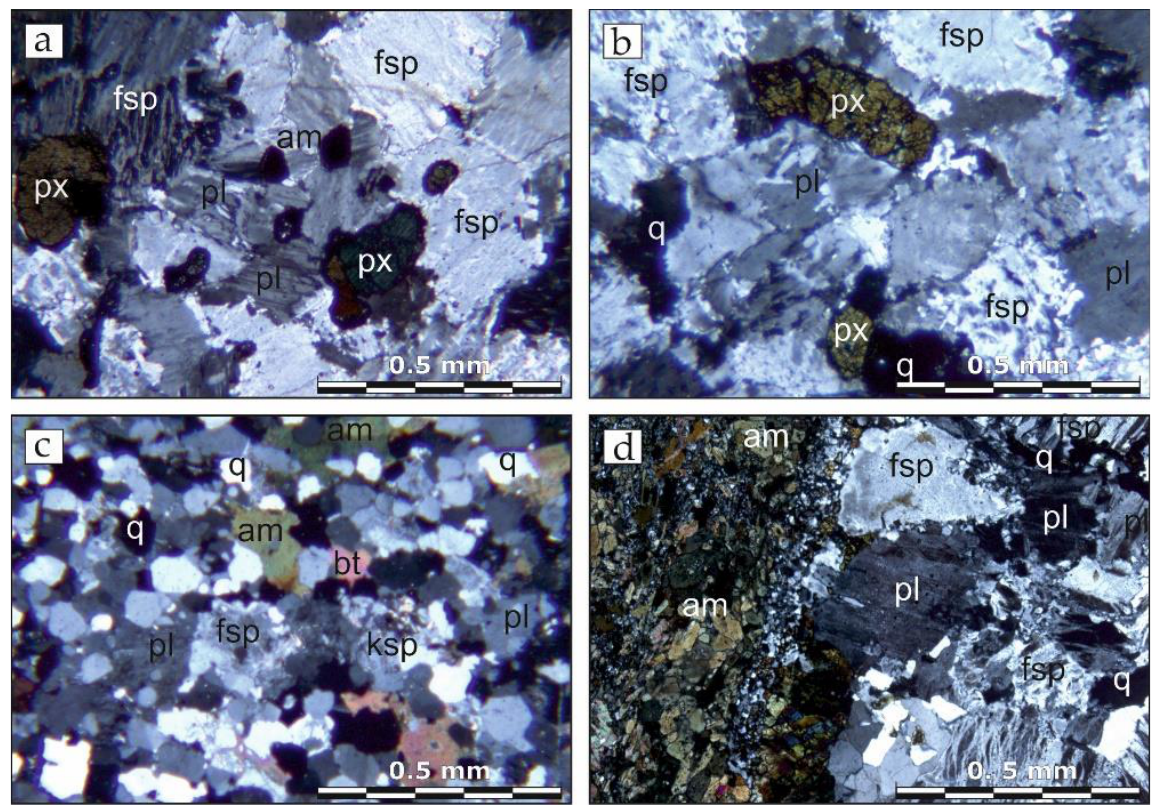
Figure 4. Textures of the Somnitelnyi massif granites. ( a,b ) Medium-grained granites in the central part of the massif; ( c ) fine-grained granites in the endocontact of the massif; ( d ) pegmatoid texture of granites in contact with amphibole – feldspar schists. Crossed nicols. q — quartz, fsp —